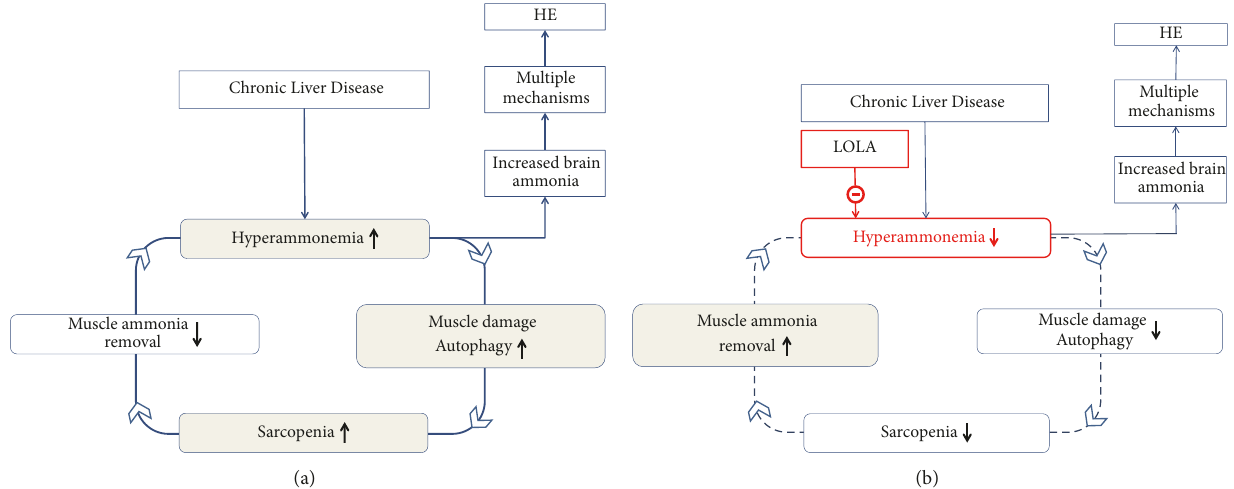
Figure 2: (a) Schematic representation of a vicious cycle by which hyperammonemia in cirrhosis resulting from diminished hepatic ammonia removal and portal-systemic shunting of venous blood results in muscle damage characterized by impairment of proteostasis and autophagy, the hallmarks of sarcopenia. Sarcopenia results in decreased capacity for ammonia removal by the muscle leading to enhancementof hyperammonemia and the cyclecontinues.(b) Treatmentwith LOLA results inreduction of hyperammonemia via metabolic and hepatoprotective mechanisms leading to a reduction of muscle damage and sarcopenia with consequent restoration of muscle glutamine synthesis, an additional mechanism implicated in the lowering of blood ammonia by LOLA in chronic liver disease. Direction and magnitude of changes in components of the cycle in this figure are indicated by